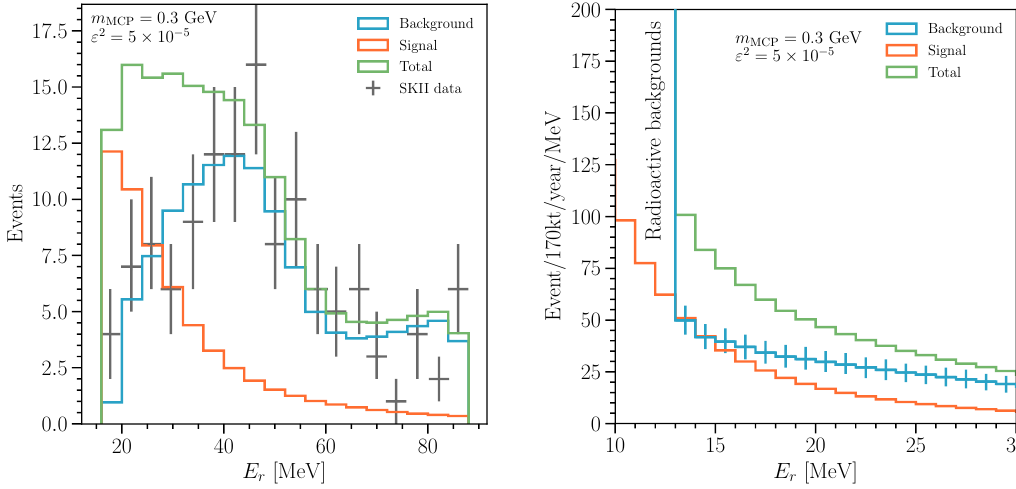
Figure 6 . Event distribution illustrations for Super-Kamiokande and JUNO. Left: electron events measured in Super-Kamiokande are shown as crosses, total backgrounds are shown as a blue histogram, and a potential MCP hypothesis is shown in orange. Right: expected distribution of MCP events in JUNO overlaid with backgrounds. Note that we have chosen m χ = 300 MeV in this figure, in contrast to previous ones, to select a point in ( m χ , ε 2 ) parameter space that yields interesting event rates without being excluded by existing